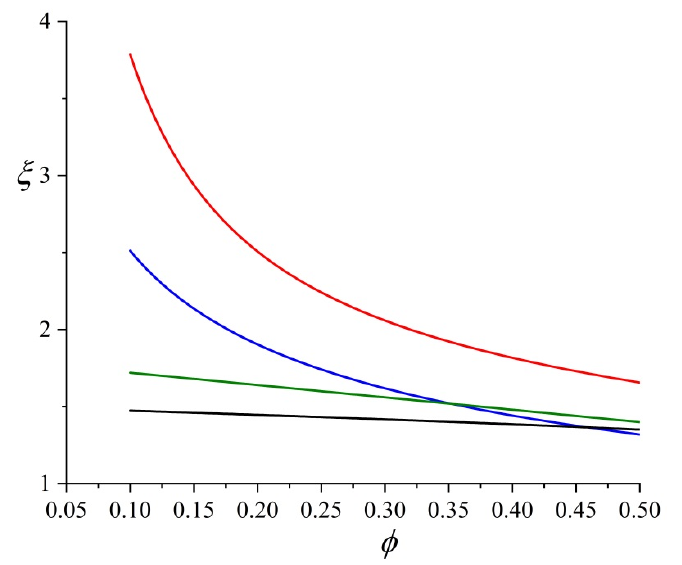
Figure 1. Comparison of tortuosity models. (Red curve [23], Blue curve [17], Green curve [18] and Black curve[22] )